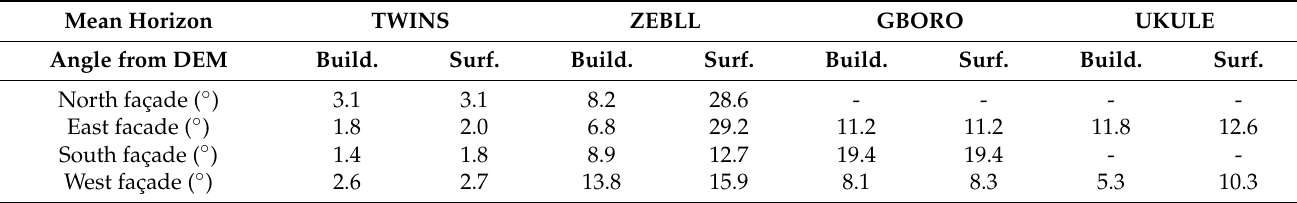
Table 3. Calculated average shading angle at mid-façade height filtered by terrain and building outlines, or without surface filtering (including all trees or other obstacles from the surface DEM). Mean Horizon TWINS ZEBLL GBORO UKULE Angle from DEM Build. Surf. Build. Surf. Build. Surf. Build. Surf. North façade ( ◦ )